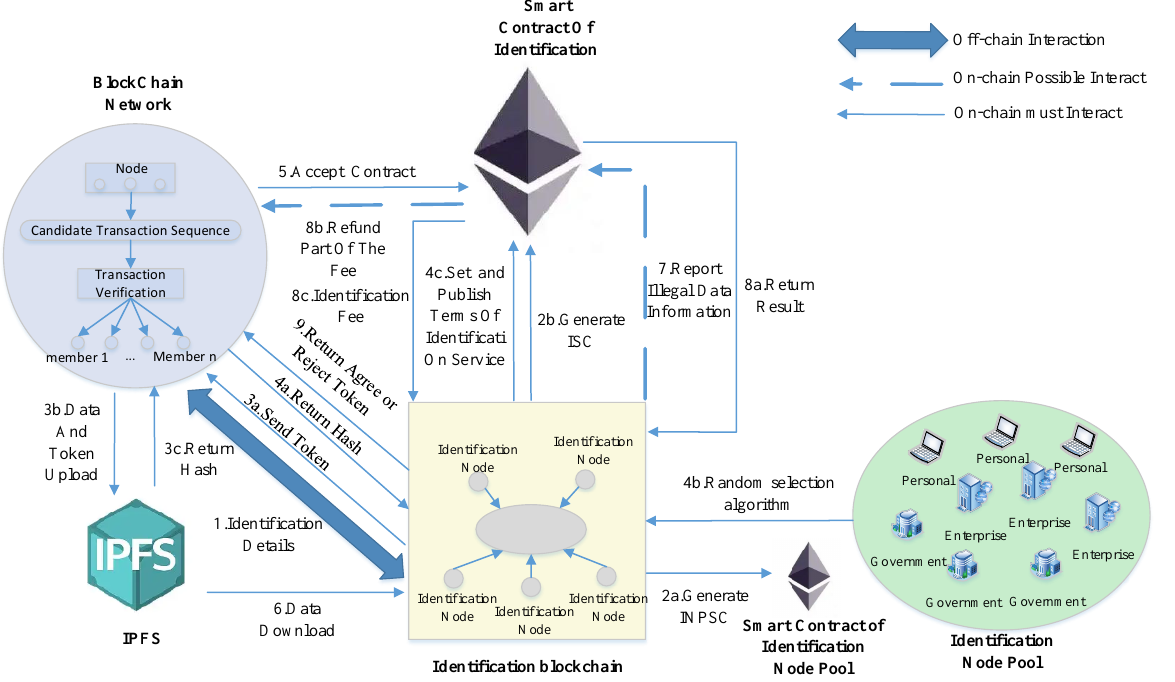
Figure 1. The overall architecture of the trust model.